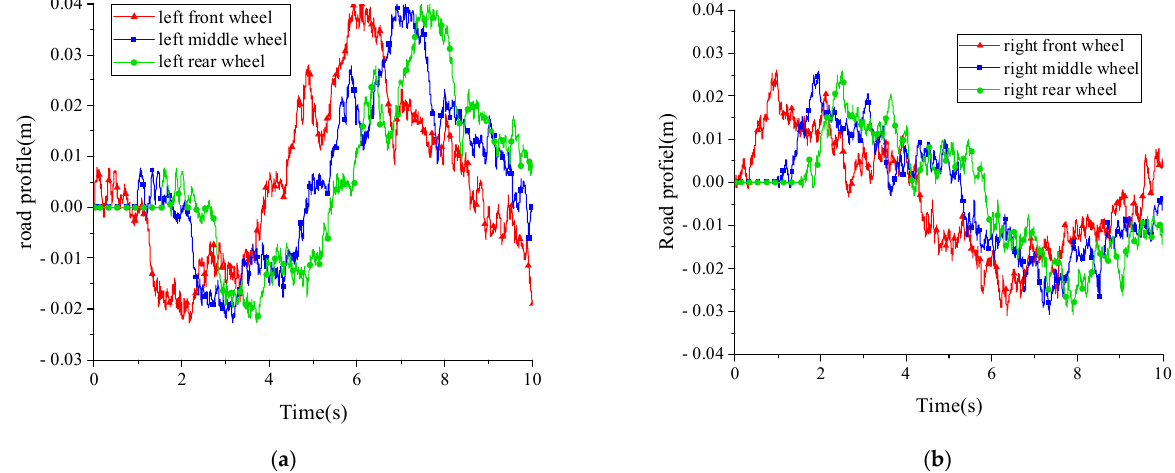
Figure 4. ( a ) Road profile of left side under stochastic signals; ( b ) road profile of right side under stochastic signals.